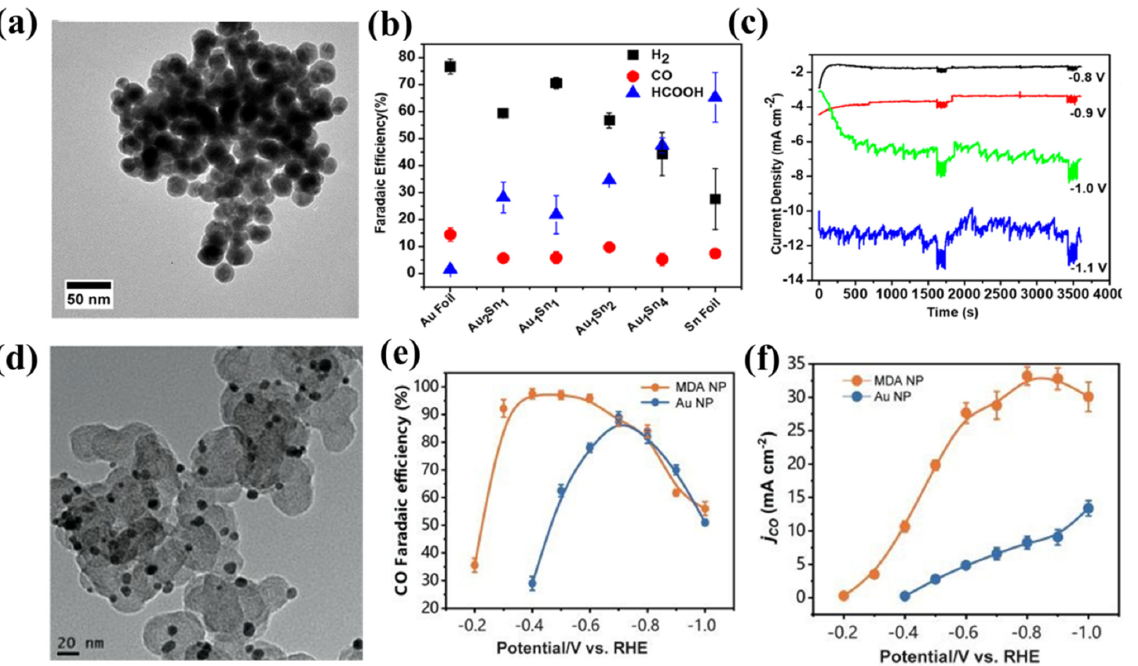
Figure 10. ( a ) TEM image of Au 1 Sn 2 catalysts. ( b ) FE as a function of composition at − 1.0 V vs.